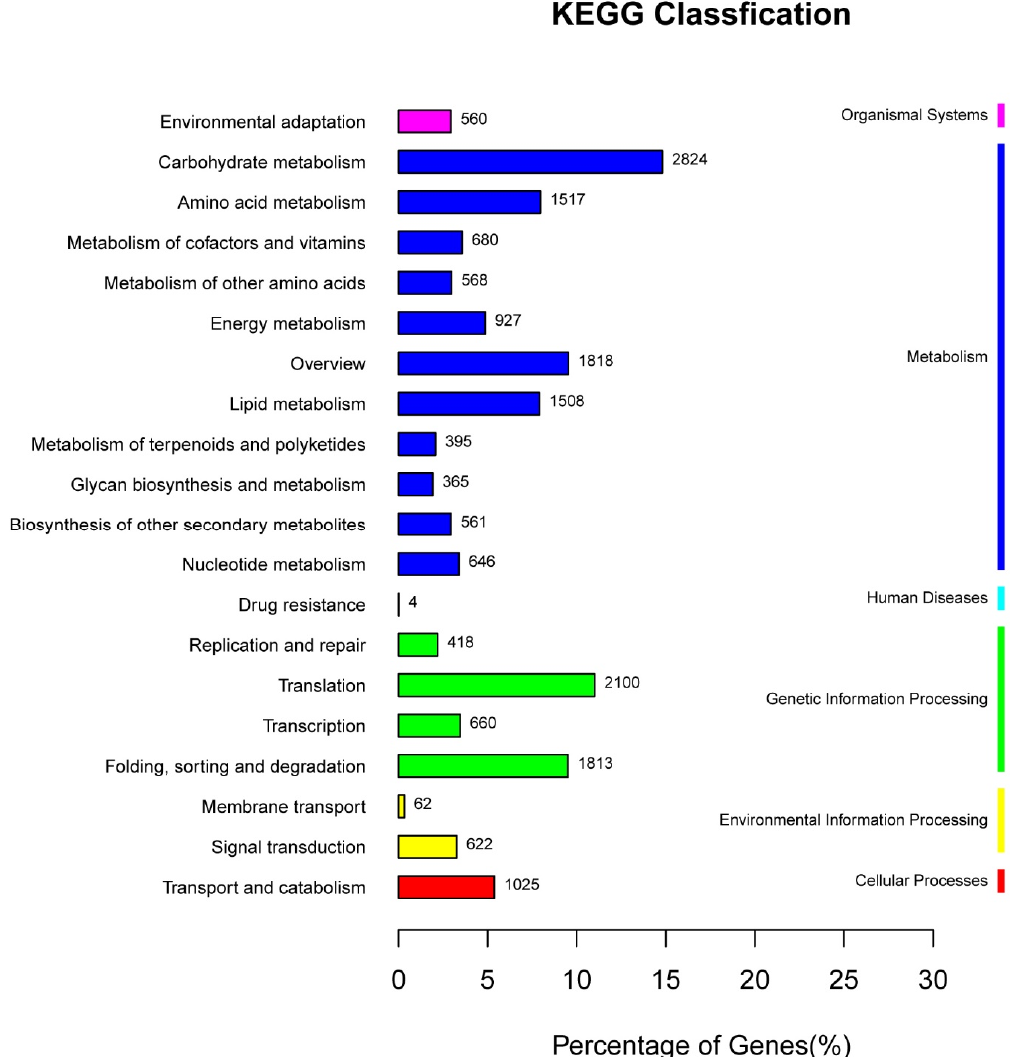
Figure 4. KEGG metabolic pathway of Styrax japonicus . The y-axis indicates the KEGG pathway, and the x-axis is the ratio of the number of unigenes.